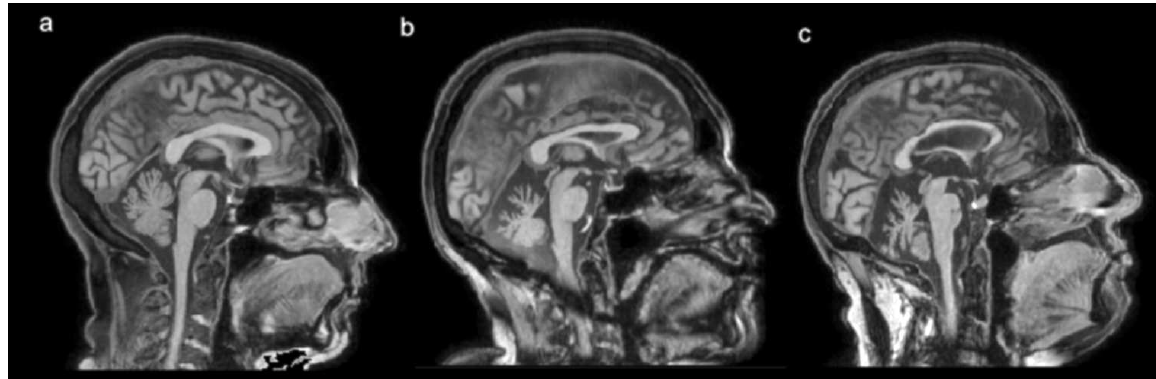
Fig. 1. MRI scans of 3 female participants with SCA6 to show progression of degeneration. a: aged 58 years, no motor symptoms at time of testing ( x = 3); b: aged 75 years, desease duration 5 years ( x = 5); c: aged 73 years, disease duration 8 years ( x = 4) (MNI)